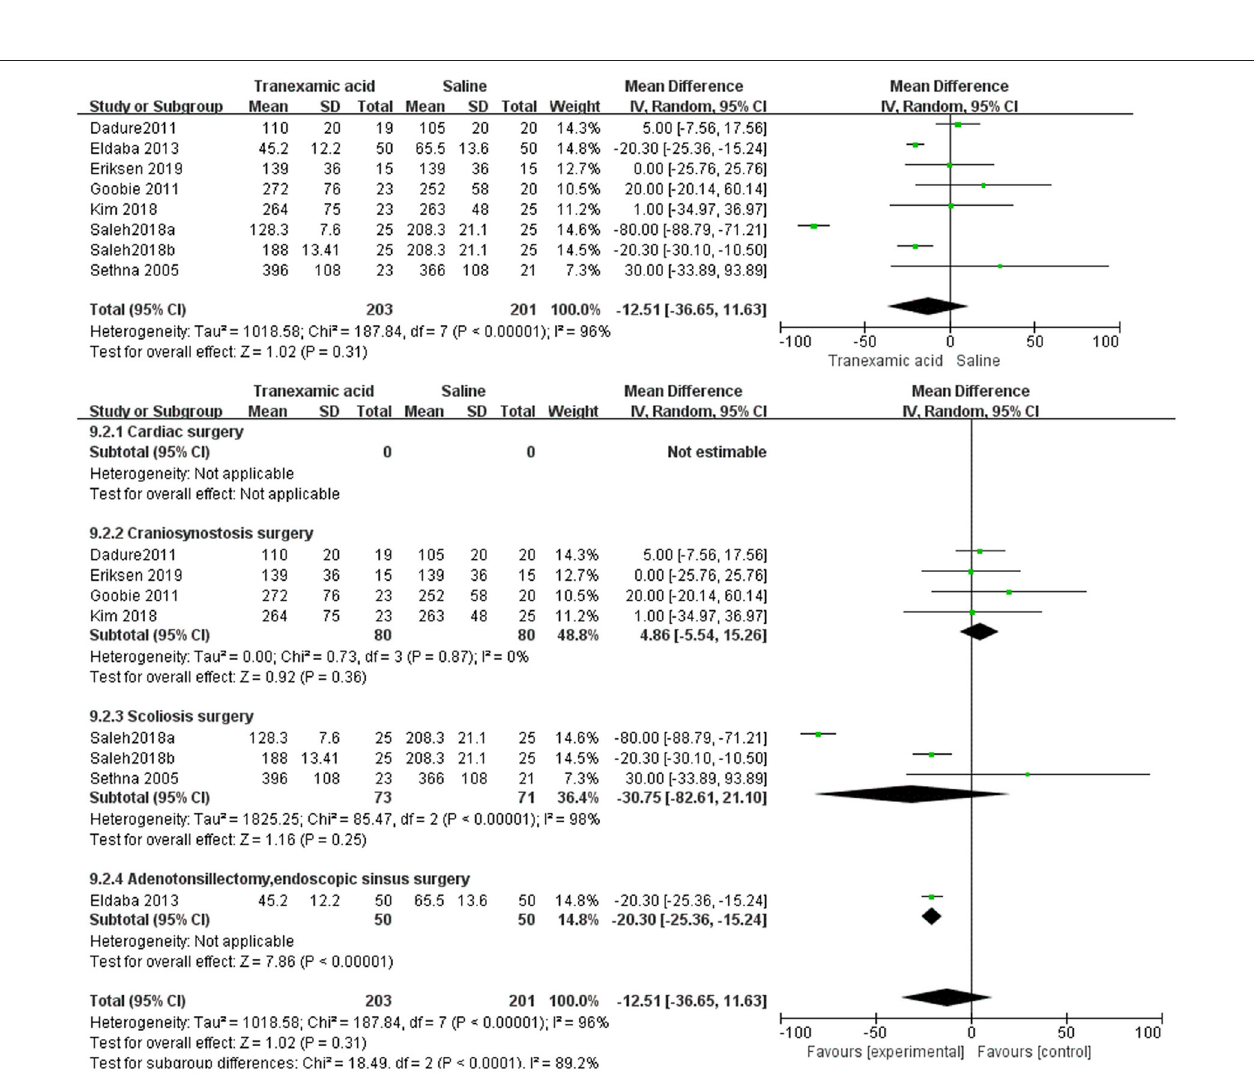
FIGURE 9 | Meta-analysis of duration of surgery for TXA compared with placebo.